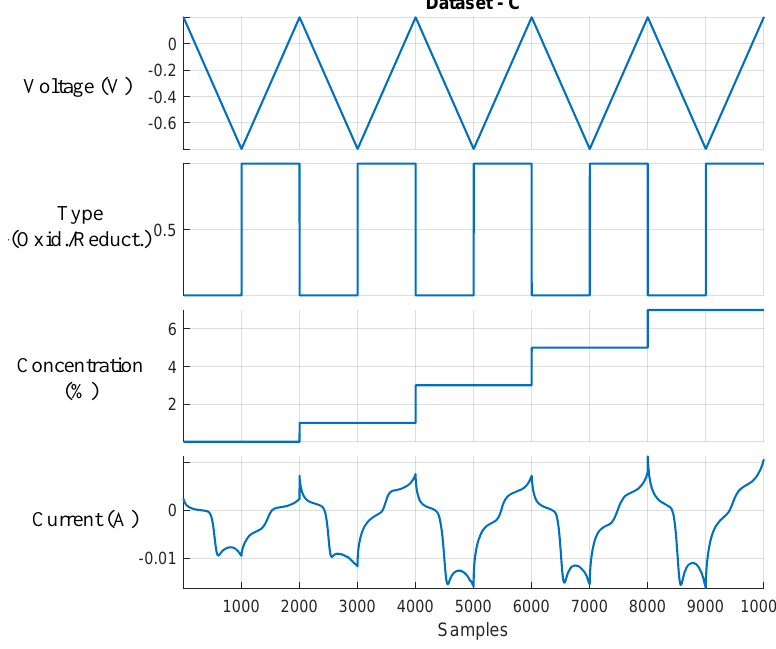
Figure 4. Distribution plot of Dataset